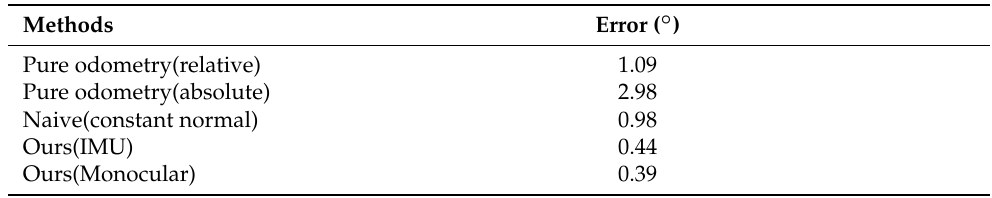
Table 3. Quantitative comparison ground plane normal estimation between our proposed methods and using odometry